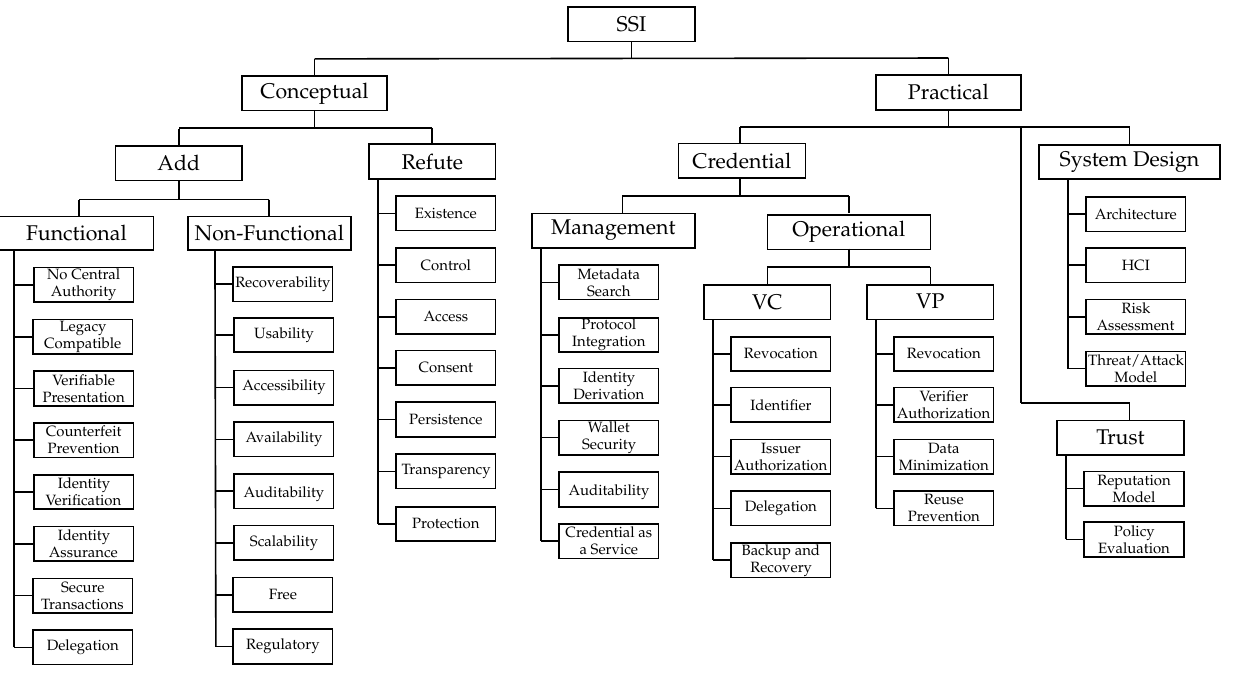
Figure 4. Taxonomy of